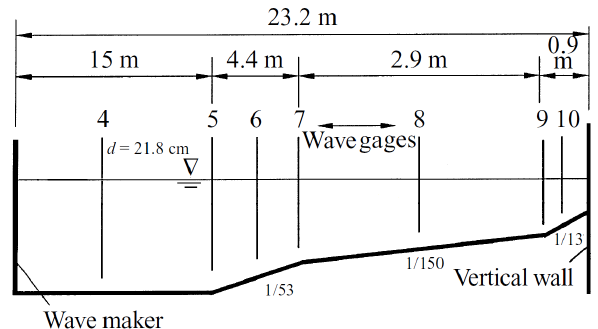
Fig. 1. Experiment